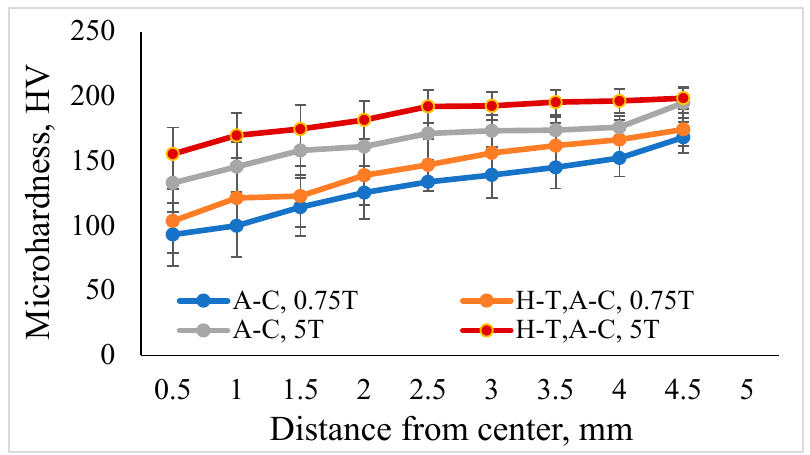
Figure 7. Microhardness plotted against distance from the disk centre of the A356 Al alloy pre-T6 (A-C) and post-T6 heat treatment (H-T, A-C) after 0.75 and 5 turns.